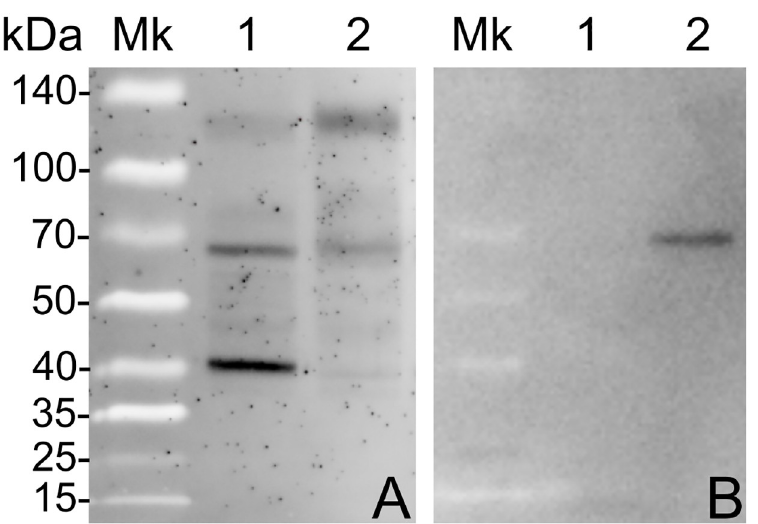
Fig 6. SDS-PAGE (A) and immunoblot (B) of tegument extracts from control FhNEJ (1) and FhNEJ after intestinal passage (2). (A) Sypro staining of total proteins; (B) anti-rFhSrp2 immunoblot. Molecular weights are shown in